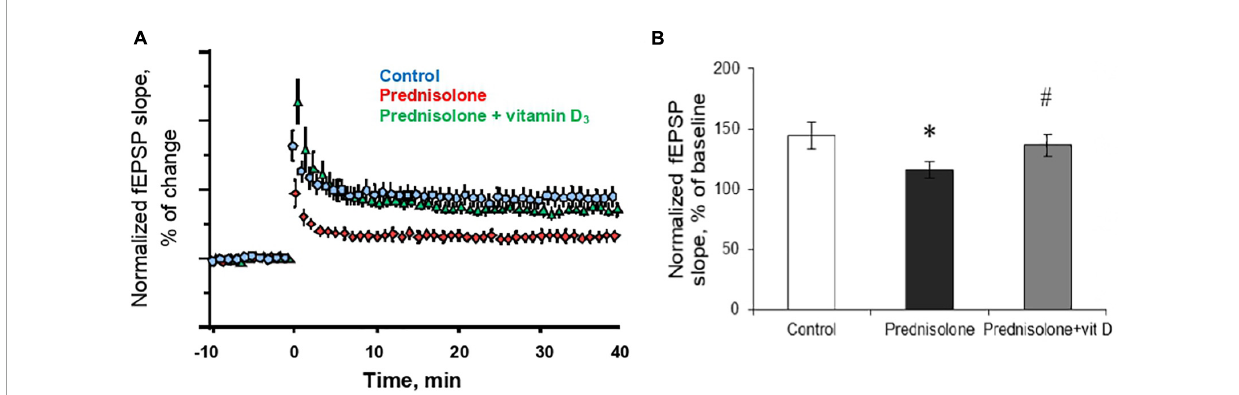
FIGURE7 Effect of vitamin D 3 on prednisolone-induced alteration of synaptic plasticity in shaffer-collateral—CA1 synapses. fEPSP slope recorded before and after tetanic stimulation was shown (A) and the normalized fEPSP amplitudes was calculated (B) for the control, prednisolone-treated and prednisolone plus vitamin D 3 -treated rats ( n = 5 rats/group). All points at panel (A) represent the average of three consecutive responses recorded every 20 s at the indicated time points. Data are presented as mean ± SD; ∗ p < 0.05 denotes significance compared with control, # p < 0.05 denotes significance compared with prednisolone